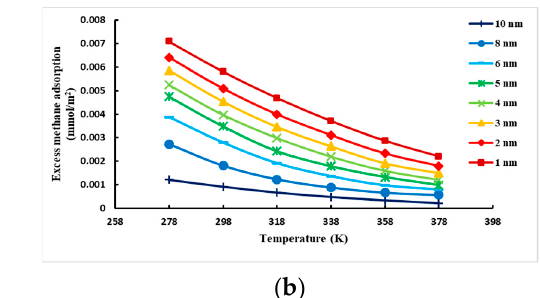
Figure 4. Partial pore size montmorillonite 3D conformation ( a ): 1 nm, ( b ): 2 nm, ( c ): 3 nm, ( d ): 4 nm, ( e ): 5 nm.